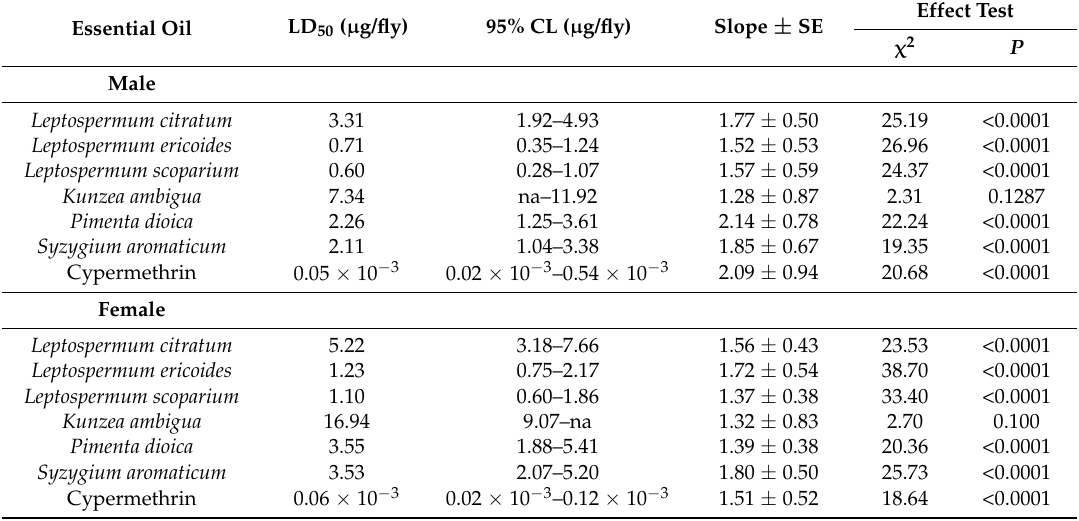
Table 3. LD 50 values of contact toxicity of essential oils against SWD.